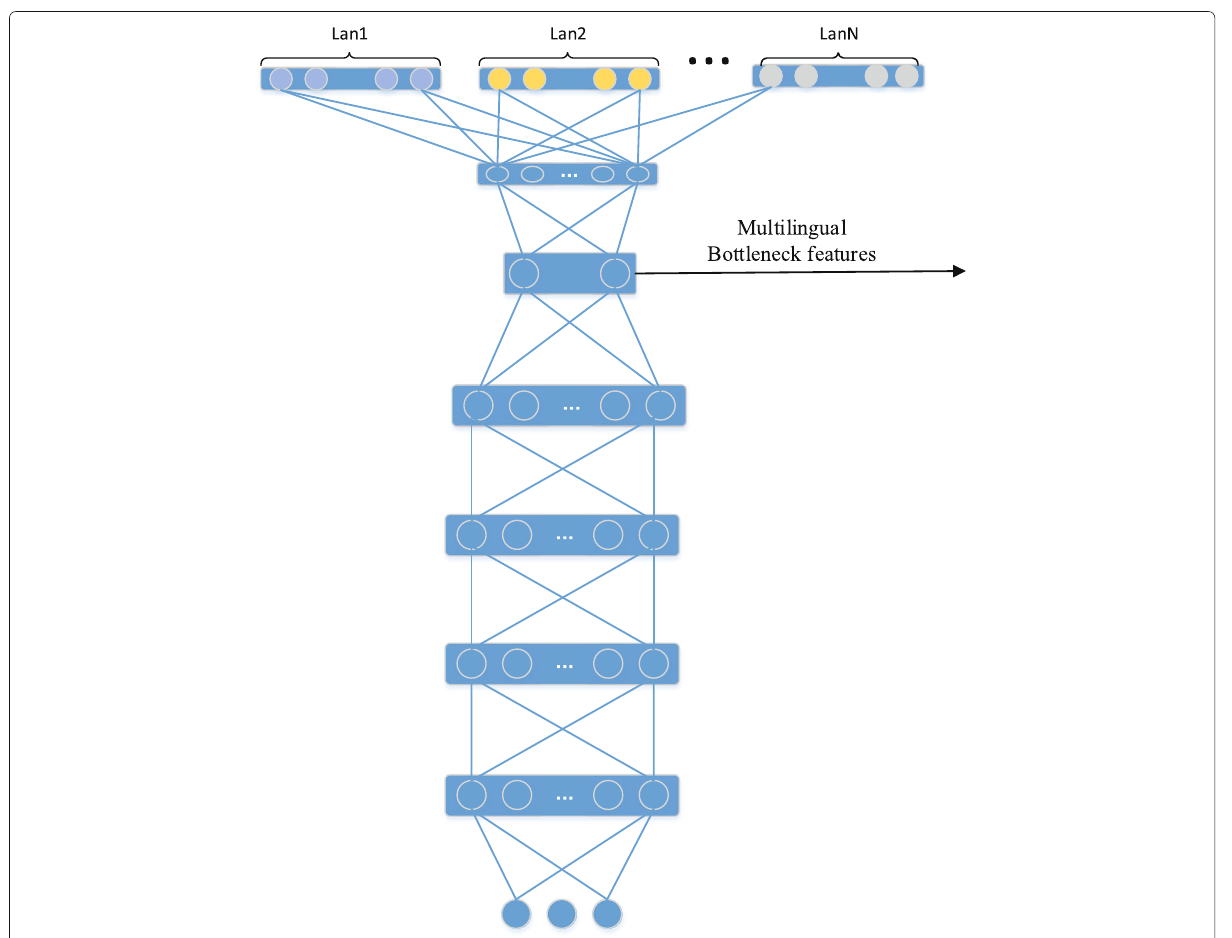
Fig. 5 The configuration of multilingual bottleneck extractor